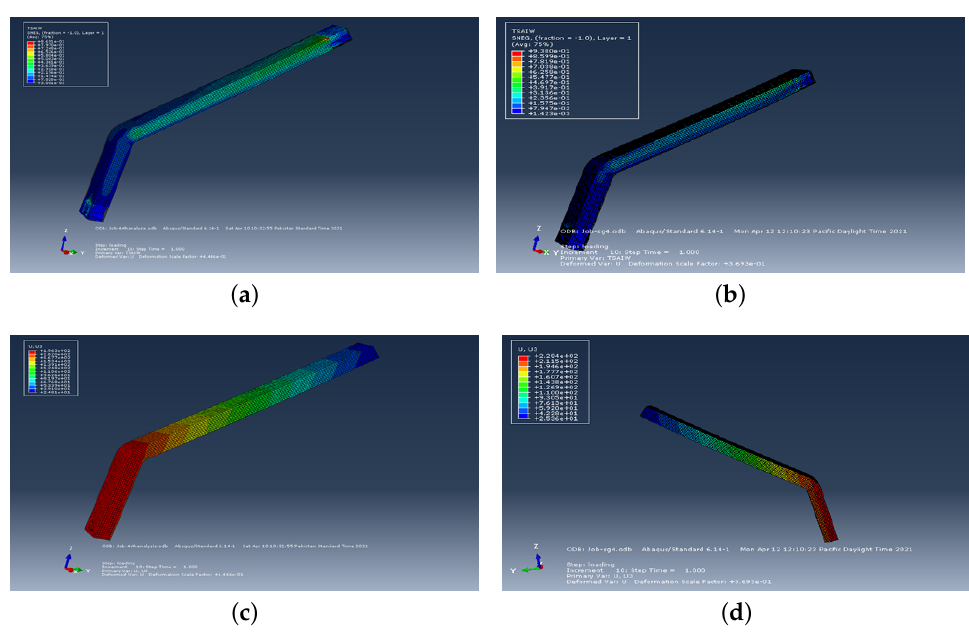
Figure 10. Results of Tsai-Wu failure criterion and deflection of main landing gear struts composed of T300 carbon fiber/epoxy and S-glass fiber/epoxy under one point landing load condition. ( a ) Tsai-Wu failure criterion of main landing gear strut composed of T300 carbon fiber/epoxy. ( b ) Tsai-Wu failure criterion of main landing gear strut composed of S-glass fiber/epoxy. ( c ) Deflection of main landing gear strut composed of T300 carbon fiber/epoxy. ( d ) Deflection of main landing gear strut composed of S-glass fiber/epoxy.